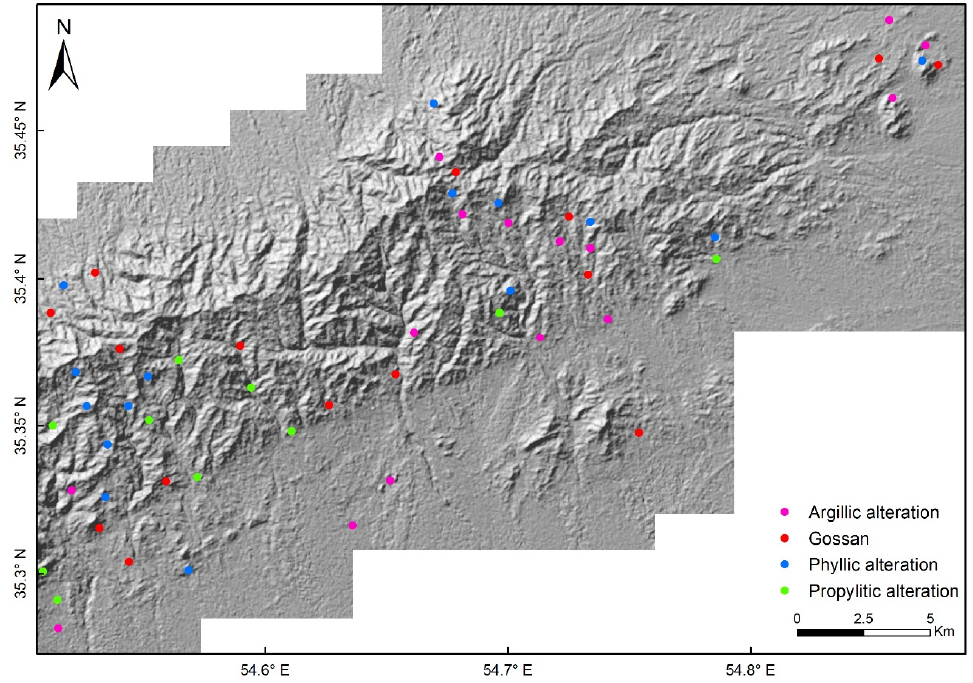
Figure 15. Samples collected from different alteration zones overlaid on the hillshade of the study area. Table 9. Confusion matrices of the transformation techniques used for enhancing different alteration types.